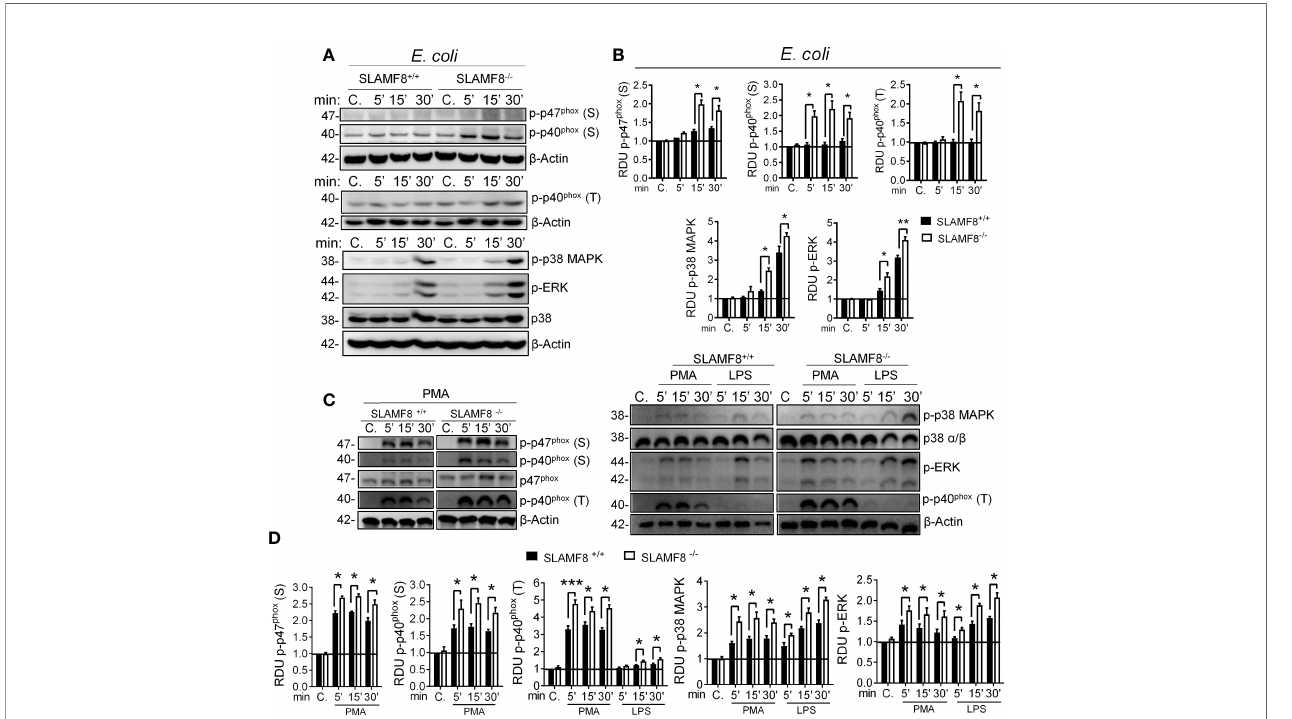
FIGURE 1 | SLAMF8 -/- pMø show increased activation of NOX2 subunits and MAPK upon stimulation with bacteria or an agonist. Analysis of phosphorylated p47 phox and p40 phox NOX2 subunits, as well as ERK1/2 and p38 MAPK in wt and SLAMF8 -/- pMø upon stimulation with E. coli (MOI 10), 100 ng/ml PMA, or 10 µg/ ml pure LPS at different time points. (A, C) Representative Western blots of the analyzed proteins in pMø upon stimulation with E. coli , PMA, or LPS. Results of one out of three independent experiments is shown. (B, D) Relative expression levels of phosphorylated proteins as indicated in A and C. Relative phosphorylation levels were normalized to appropriate loading control and are graphically represented. Values indicate mean ± SEM of three independent experiments. * p < 0.05; ** p < 0.01; *** p < 0.001. C , control; S, serine; T, threonine; RDU, relative densitometry